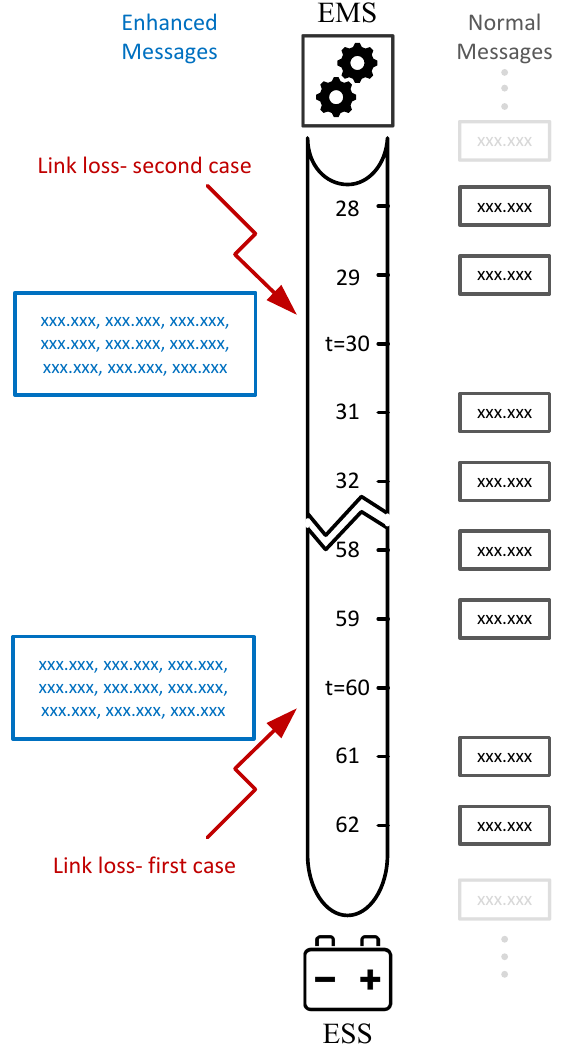
Figure 18. Two different cases of link